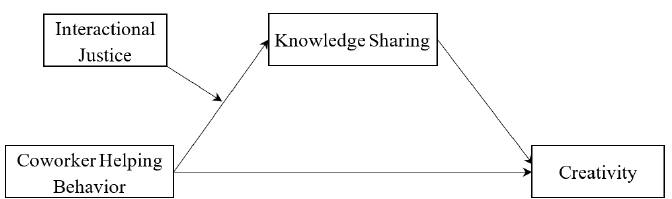
Figure 1. Hypothesized model.